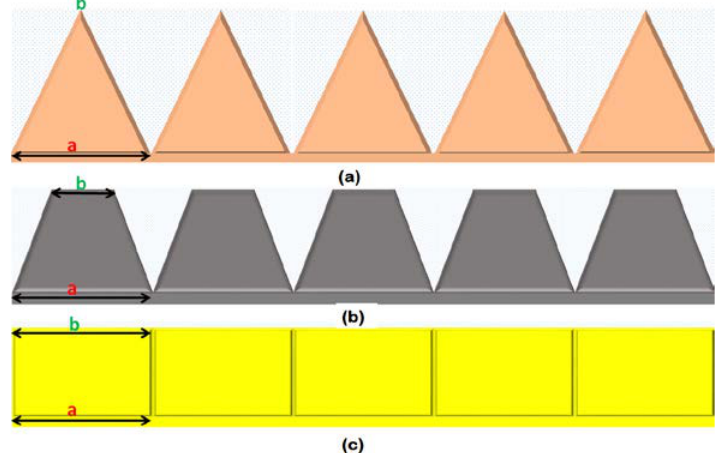
Figure 3. Schematic view of the geometrical shapes for nano-grating structures on the solar cell used for modelling and simulation. The shapes are triangular-shaped ( a ), trapezoidal-shaped ( b ), and rectangular-shaped ( c ) nano-structure.